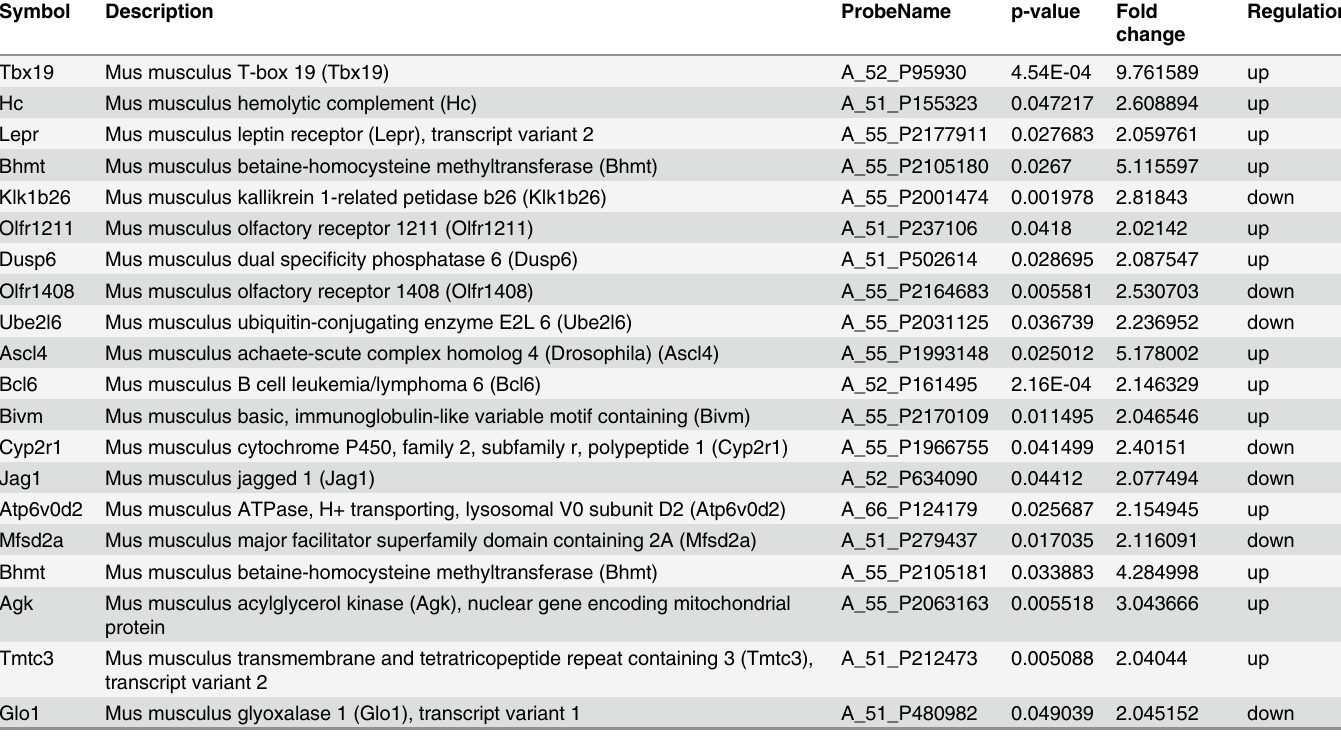
Table 2. Significant mRNA changes induced in liver of D-galactose group.